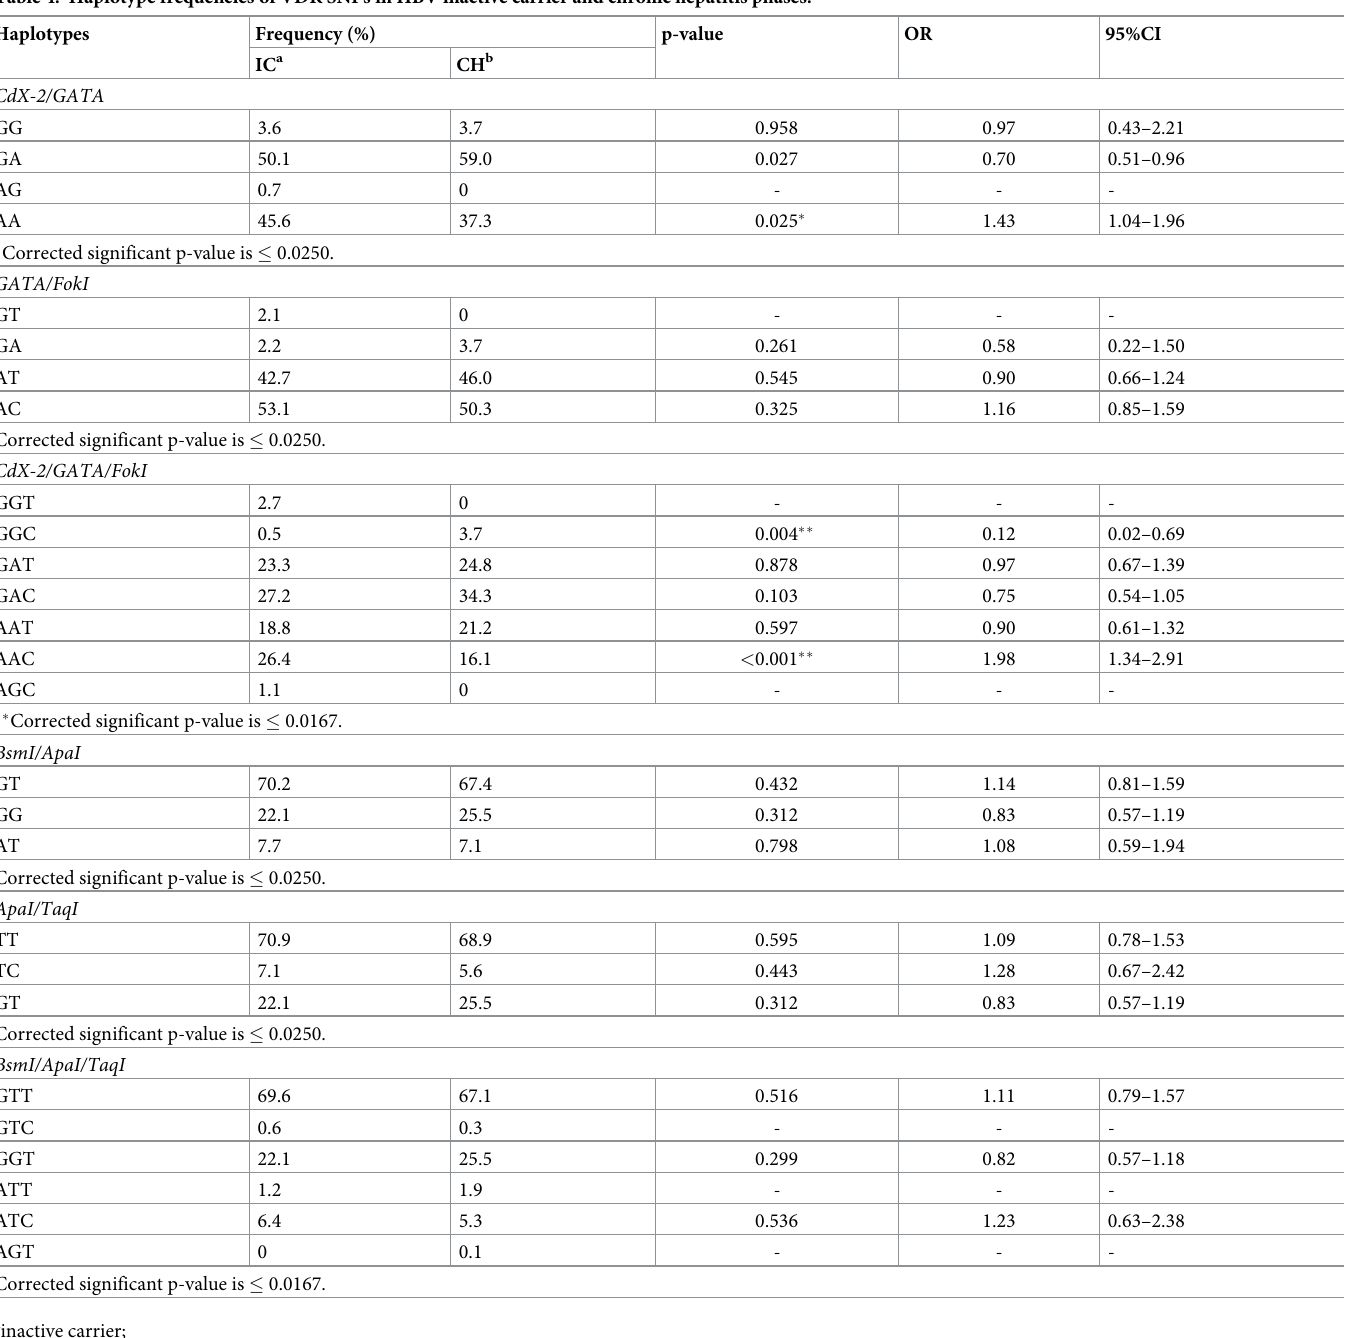
Table 4. Haplotype frequencies of VDR SNPs in HBV inactive carrier and chronic hepatitis phases.